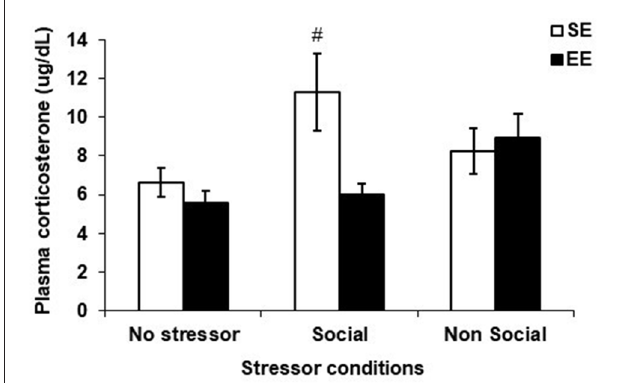
FIGURE 4 | Plasma corticosterone levels collected 90 min after the social interaction test (which acted as a Social Stressor), the elevated-plus maze (which acted as a Non-Social Stressor) or a control condition (No Stressor) among mice housed for 6 weeks in a SE or an EE. Mice housed in SE had increased plasma corticosterone levels after the Social Stressor but not the Non-Social Stressor. These corticosterone elevations were not apparent in mice housed in EE. # p < 0.05 relative to SE mice in the No Stressor condition. Data represents means ± SEM (SE mice/No stressor: n = 12; SE mice/Social: n = 12; SE mice/Non-Social: n = 12; EE mice/No Stressor: n = 11; EE mice/Social: n = 8; EE mice/Non-Social: n =